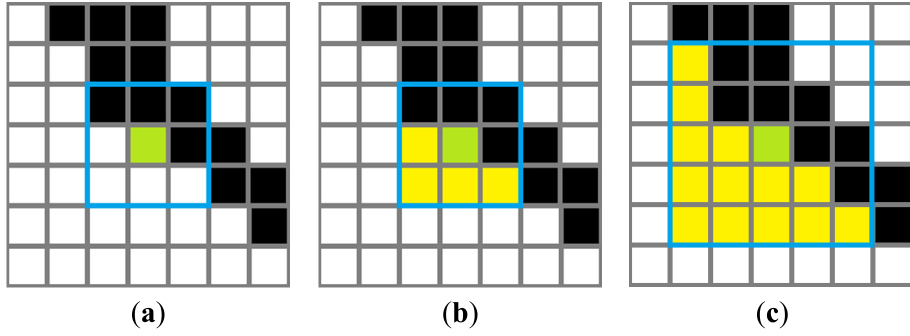
Figure 2. Adaptive window example with 3 × 3 window and N q = 8 showing ( a ) the seed pixel (light green) and the initial window outlined in turquoise ( b ) The local neighborhood within the initial window has only 5 pixels, therefore ( c ) grow the local neighborhood until it has more than N q pixels, restricted by the edge mask